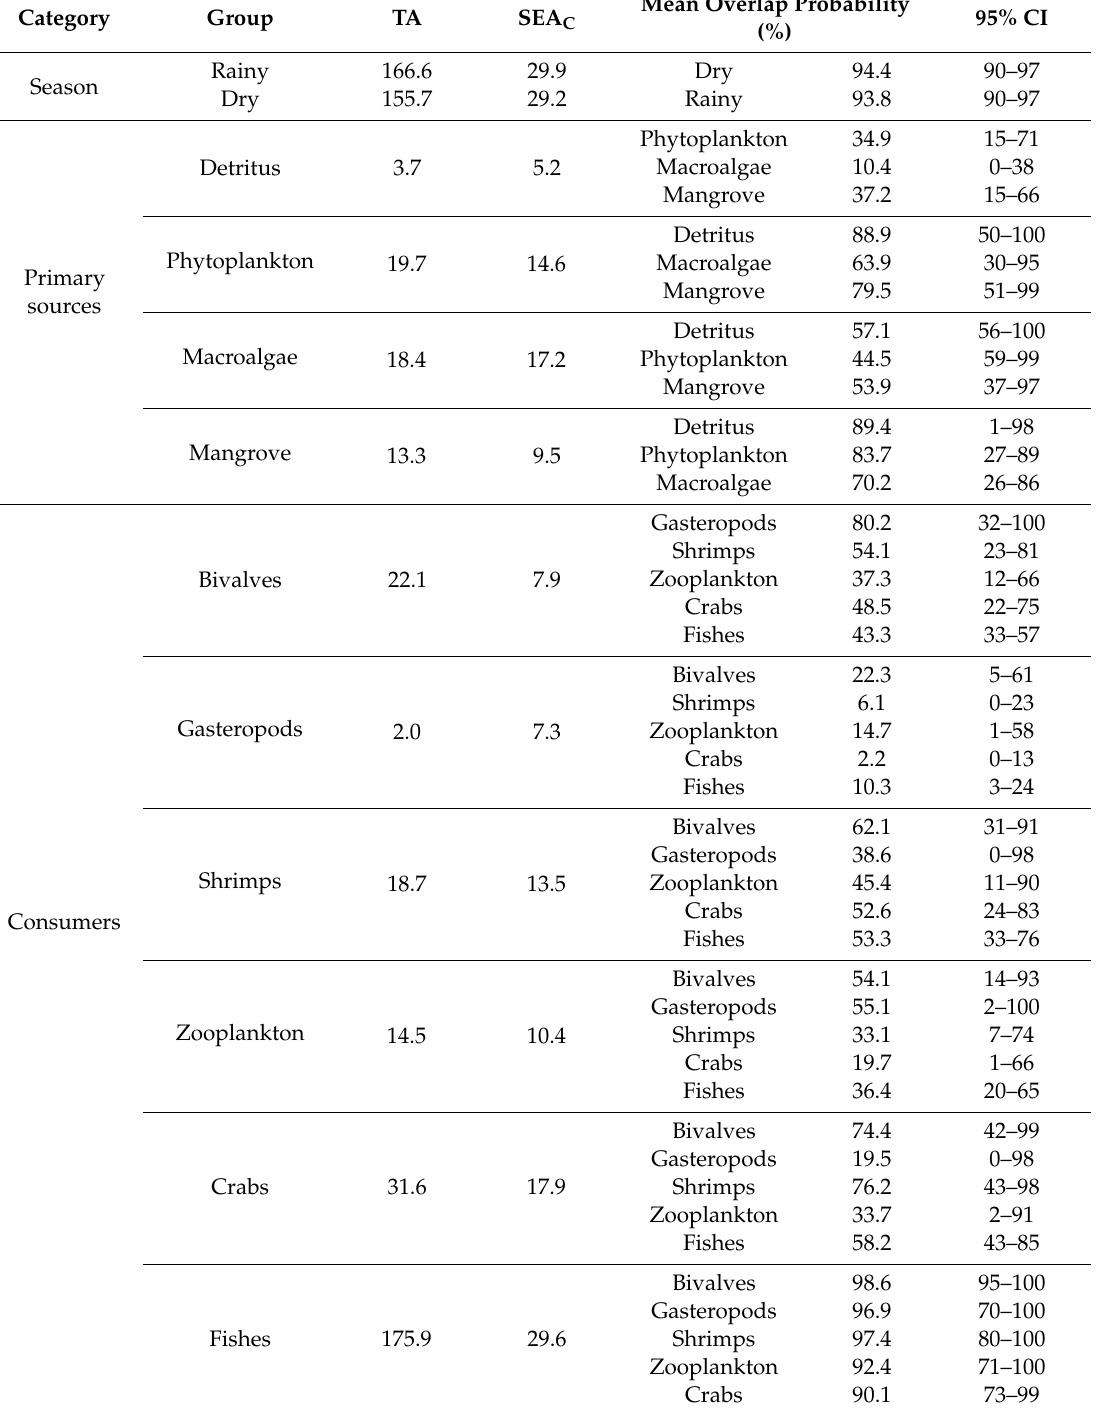
Table 2. Total area (convex hulls), mean standard ellipses areas of two-dimensional niches region, mean overlap probability of 95% niche regions (probability of group A overlapping with group B), and 95% credible intervals of each